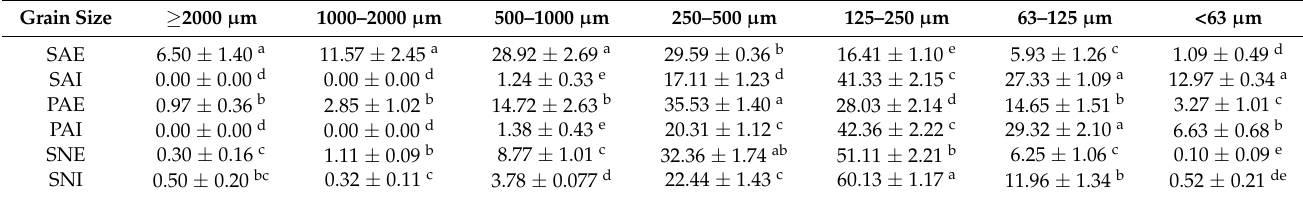
Table 1. Grain size fractions (%) in gut contents and surrounding sediments of S. australe , P. arcuatum, and S. nudus .